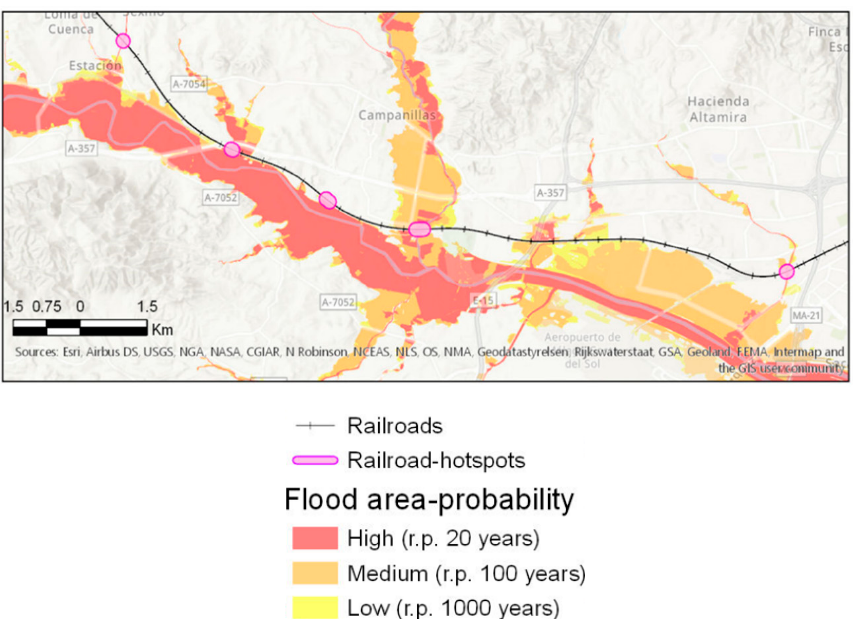
Figure 1. Exposure of railway track to floods for different flood return periods (20-years, 100-years and 1000-years) within the Málaga region, Spain. The exposed parts of the railway are indicated with pink ellipses. (Source: [44]).